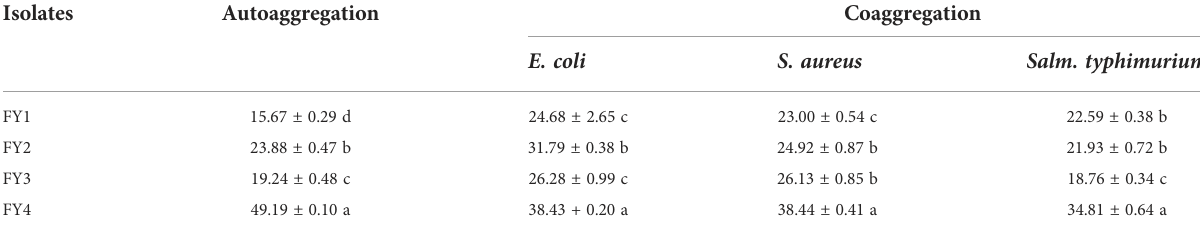
TABLE 1 The percentage of autoaggregation and coaggregation with E. coli , S. aureus , and Salm. typhimurium by four isolates.